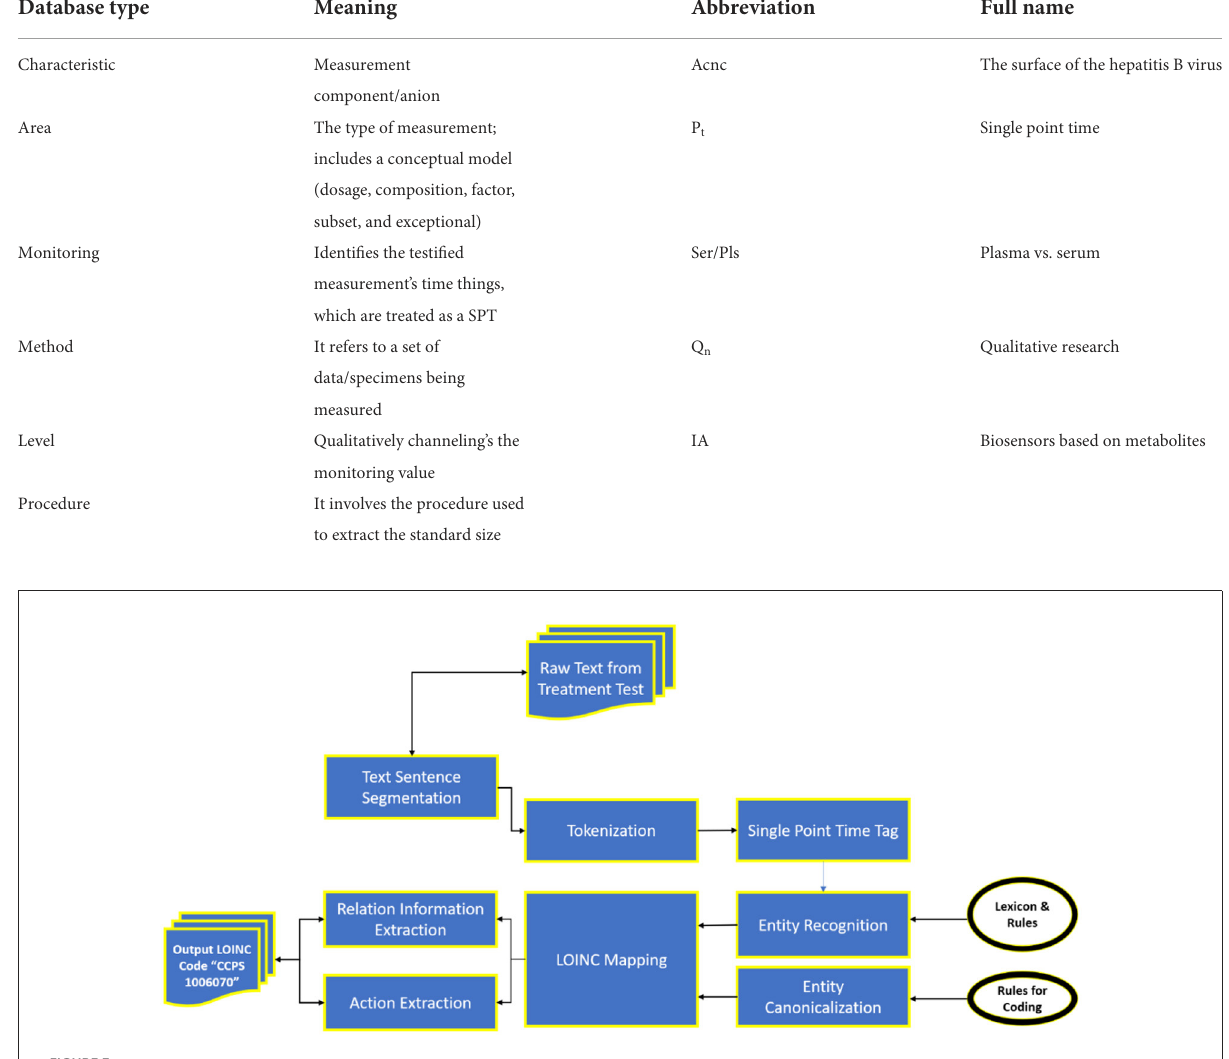
FIGURE3 Mapping of LOIN codes and